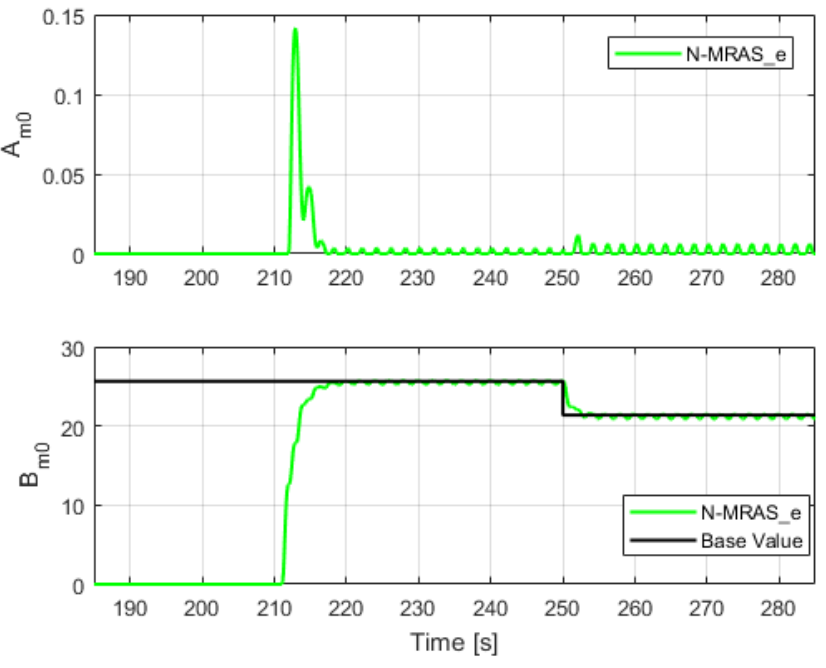
Figure 12. N-MRAS_m behaviour for a sudden increase of 20% of the motor inertia.